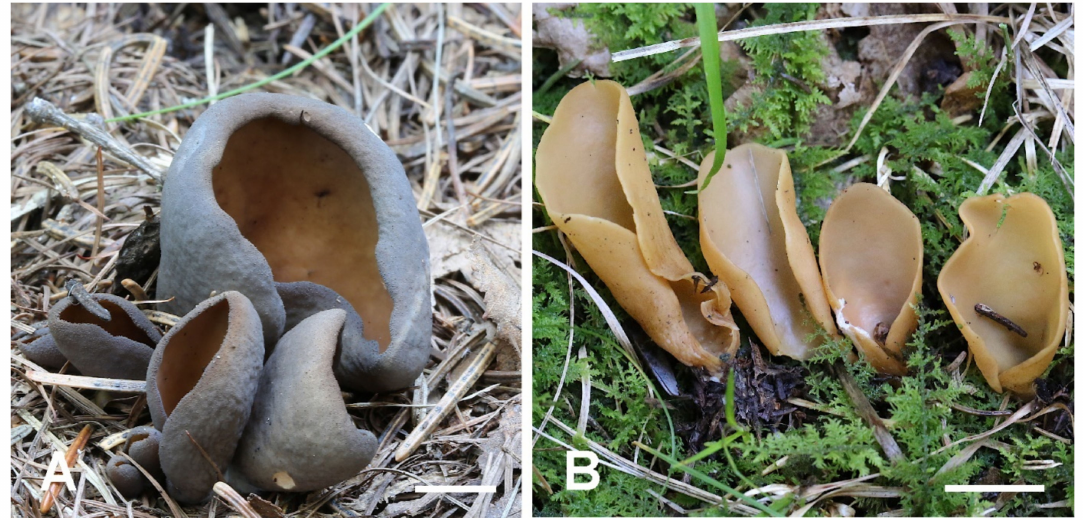
Figure 10. Two new record species from China. ( A ) Otidea mirabilis (HSA 234), ( B ) Otidea nannfeldtii (BJTC FM236). Scale bars: ( A , B ) = 1